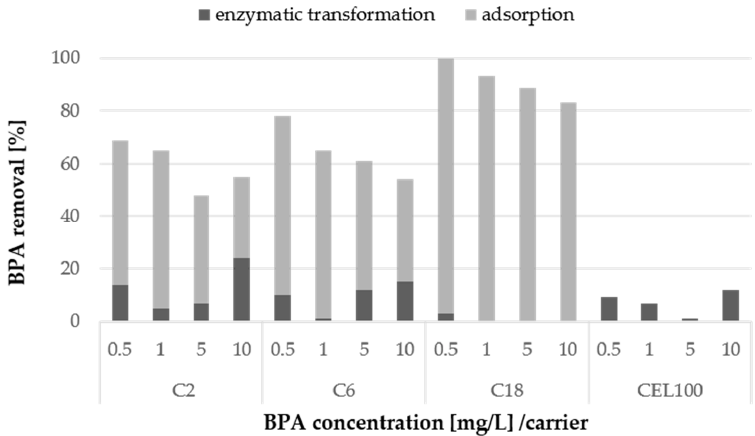
Figure 8. Enzymatic transformation of BPA at a concentration from 0.5 mg / L to 10 mg / L using adsorbed or covalently immobilised laccase and removal of BPA via adsorption on the surface of non-modified selected carriers after 72 h. The standard error of the results did not exceed 5%. To maximise the BPA transformation using immobilised LAC, the higher activity of 12 U/L was applied. This increased the share of enzymatic transformation over adsorption in the BPA loss up to 39%, 45% and 21% for the C2C carrier, the C6C carrier, and the CEL100 membrane, respectively (Figure 9). The best rate of BPA enzymatic degradation obtained for the C6C carrier was 45%, which corresponds to 0.063 mg/L/h of BPA removal. This result was comparable to results obtained for laccase from Trametes versicolor immobilised on Hippospongia communis , i.e., 0.08 mg/L/h of BPA removal, and even higher than those reported for Coriolopsis gallica laccase immobilised on silica beads (>0.03 mg/L/h of BPA removal) [33,34]. Noteworthy, our results were obtained using nearly 5- times lower LAC activity than the activity of C. gallica LAC [33].